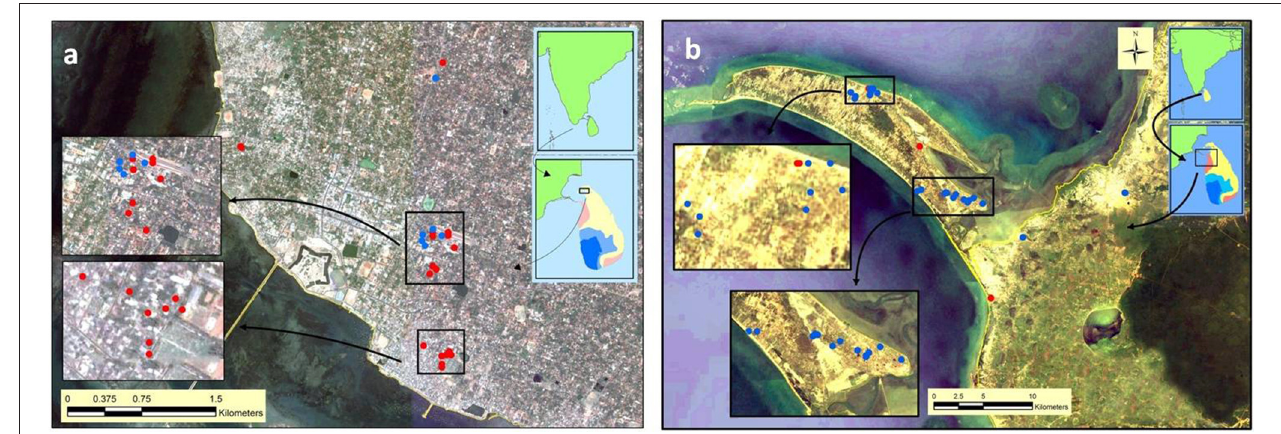
FIGURE 3 | Map showing sites surveyed for anopheline larvae in (a) Jaffna and (b) Mannar. Red and blue solid circles, respectively, show An. stephensi positive and negative sites in the two